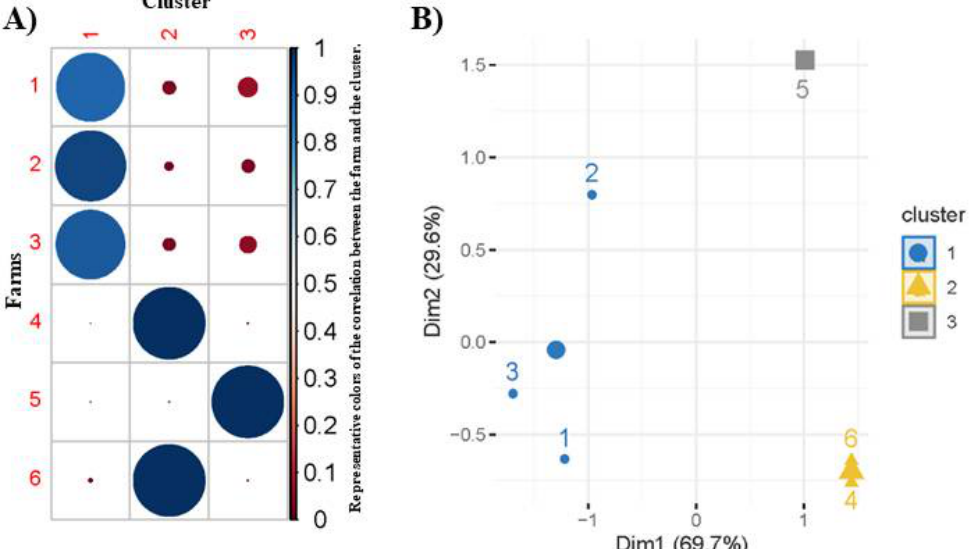
Figure 2. ( A ) Correlation of each farm, based on the variables under analysis, with the cluster to which it belongs and with the other clusters, values closer to 1 (darker blue) mean greater correlation and closer to zero (red) less correlation (color palette associated with the degree of correlation is on the right of Figure 2A), it is possible to visualize 3 clusters (columns) and 6 farms (rows), and ( B ) representation of the groups formed by the farms from the analyzed variables (temperature, precipitation, and altitude), it is possible observed 3 clusters (different colors) formed by the variables of the 6 farms, each farm is represented by its identification number that varies from 1 to 6. We verified that, with the parameters used, the farms formed 3 distinct groups, based on these edaphoclimatic characterization results: group 1 formed by farms 1, 2, and 3; group 2 formed by farms 4 and 6; group 3 formed by farm